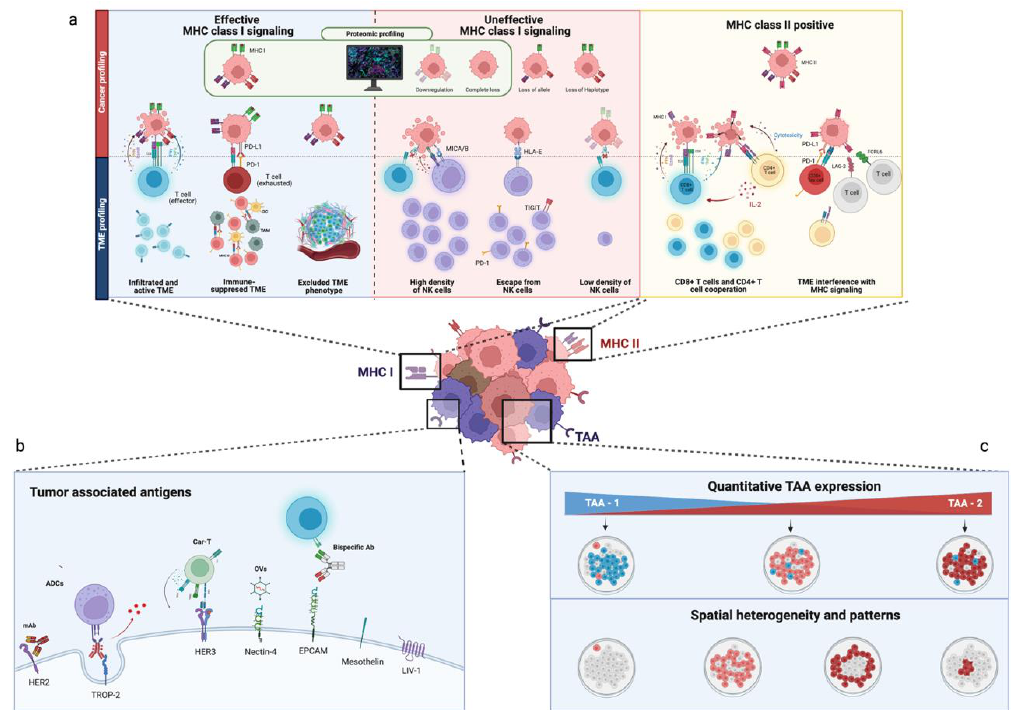
Figure 1. Multiplexed spatial protein profiling of breast cancer antigenicity. ( a ) Major histocompat- ibility complex (MHC) class I and II cancer (upper quadrants) and TME profiling (lower quadrant).